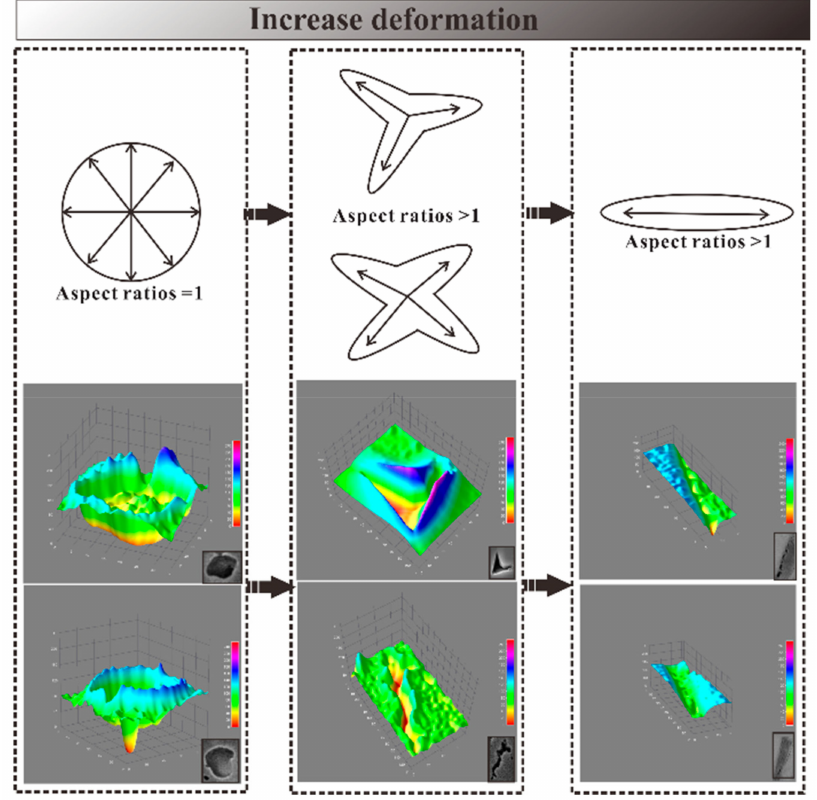
Figure 9. Evolution of the OM pore aspect ratio with increasing tectonic